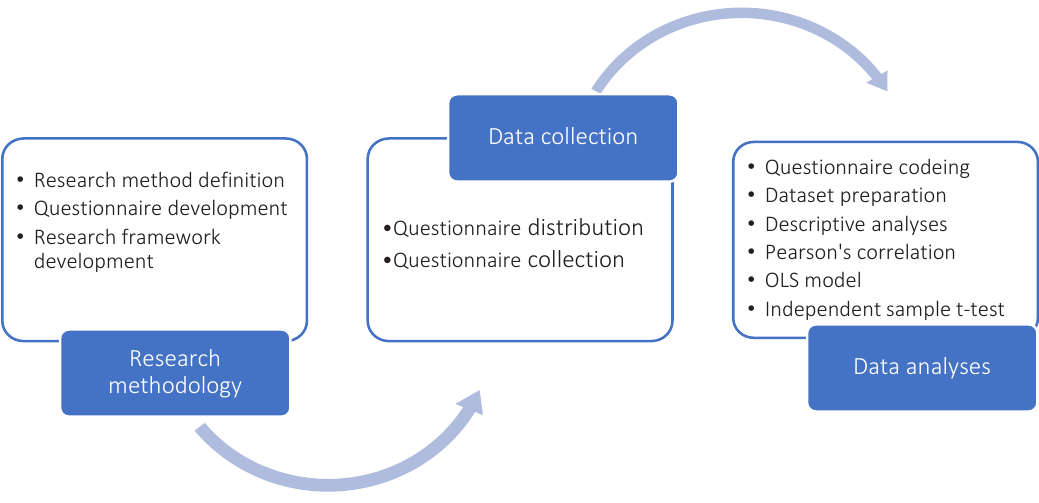
Figure 1. Methodology flowchart